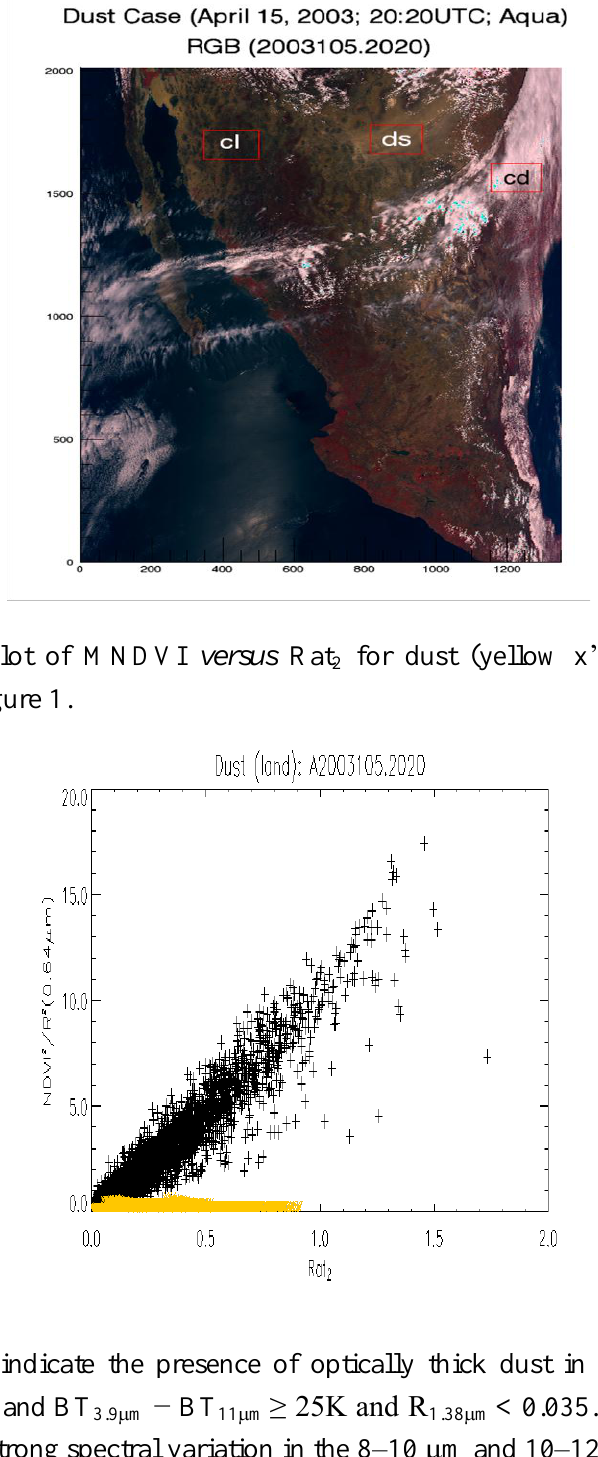
Figure 1. Aqua MODIS RGB image for a granule with dust plume over Mexico. cl, ds, and cd symbols represent clear-sky, dust, and cloud, respectively.